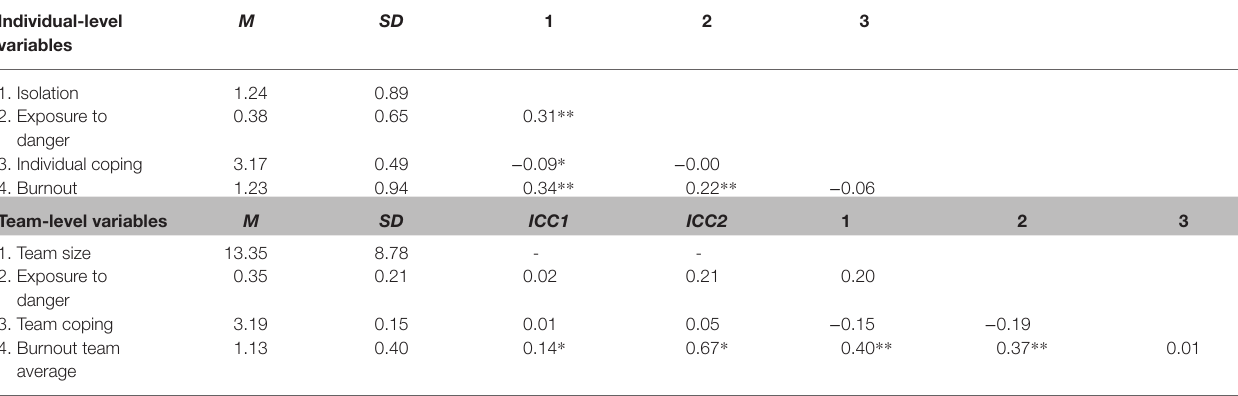
TABLE 1 | Means, standard deviations, and correlations of the study variables. Individual-level